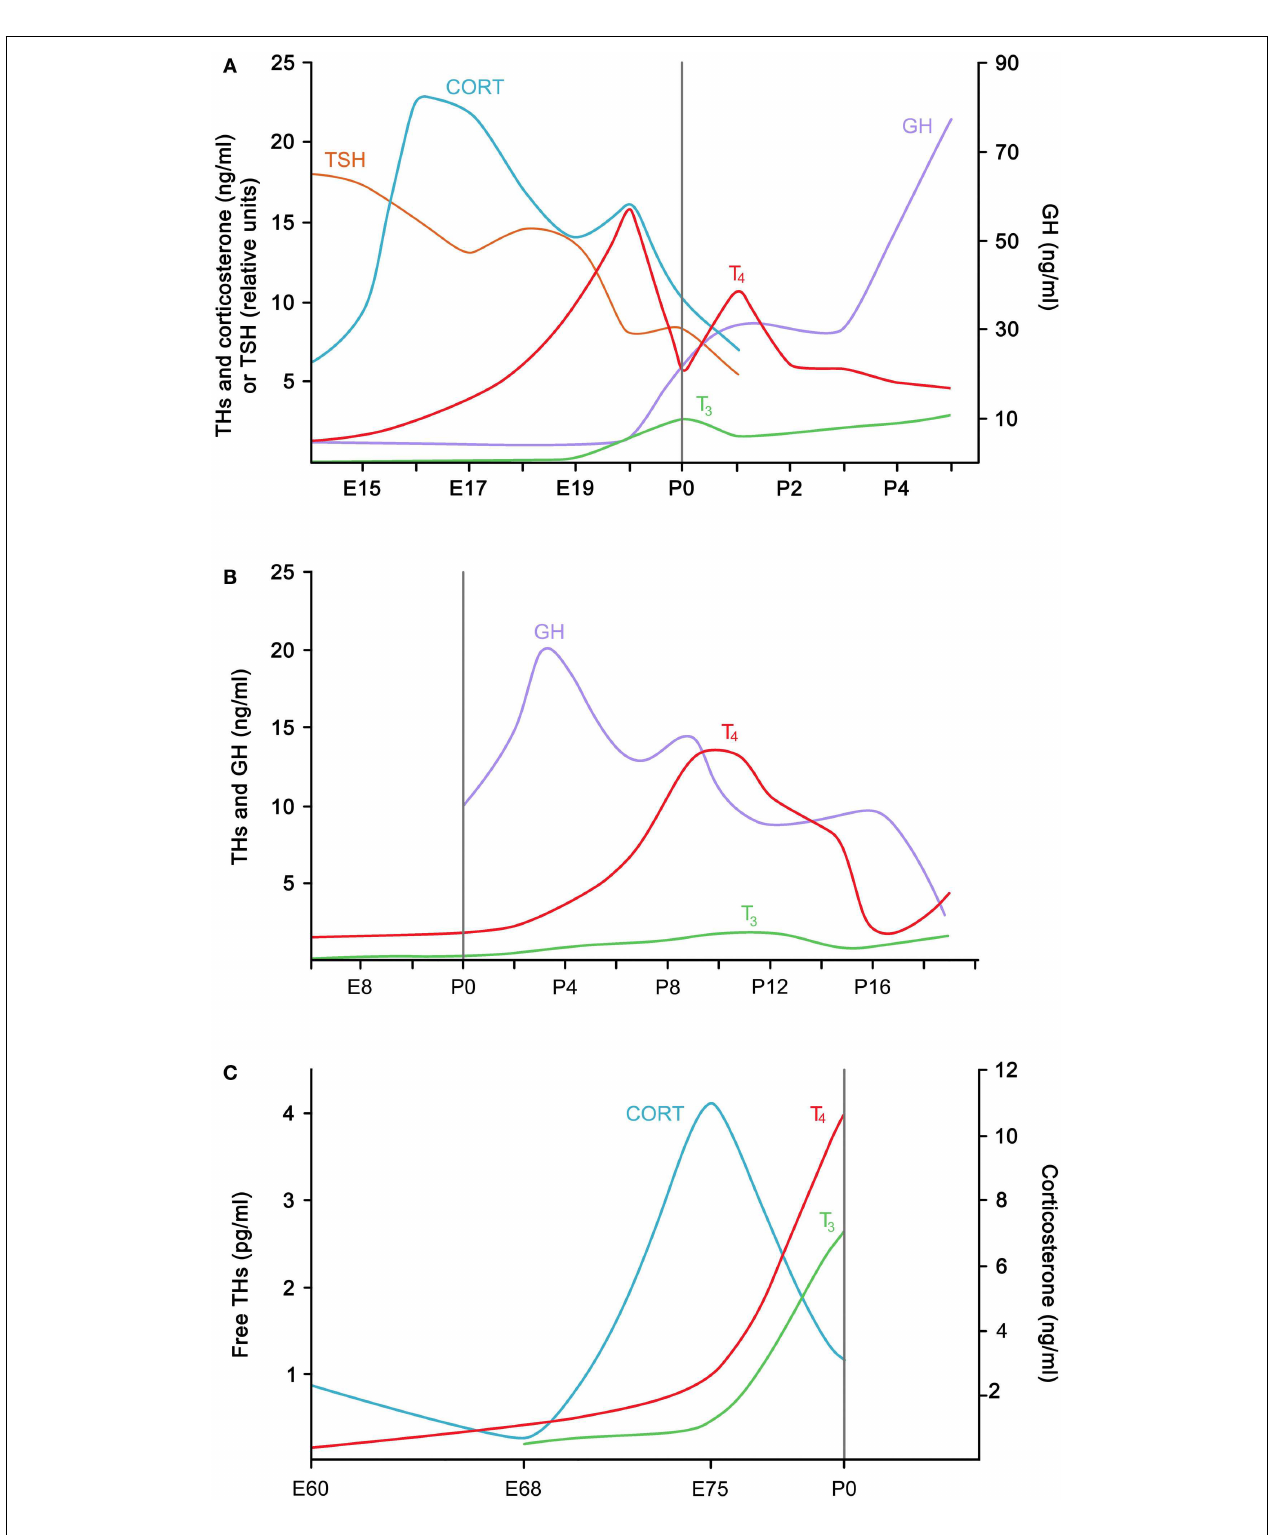
FIGURE 1 | Generalized ontogenic patterns of plasma hormones associated with hatching in (A) a precocial bird (chicken) (after Darras et al., 1992; Geris et al., 1998; and De Groef et al., 2006a), (B) an altricial bird (European starling) (after Schew et al., 1996) and (C) a non-avian